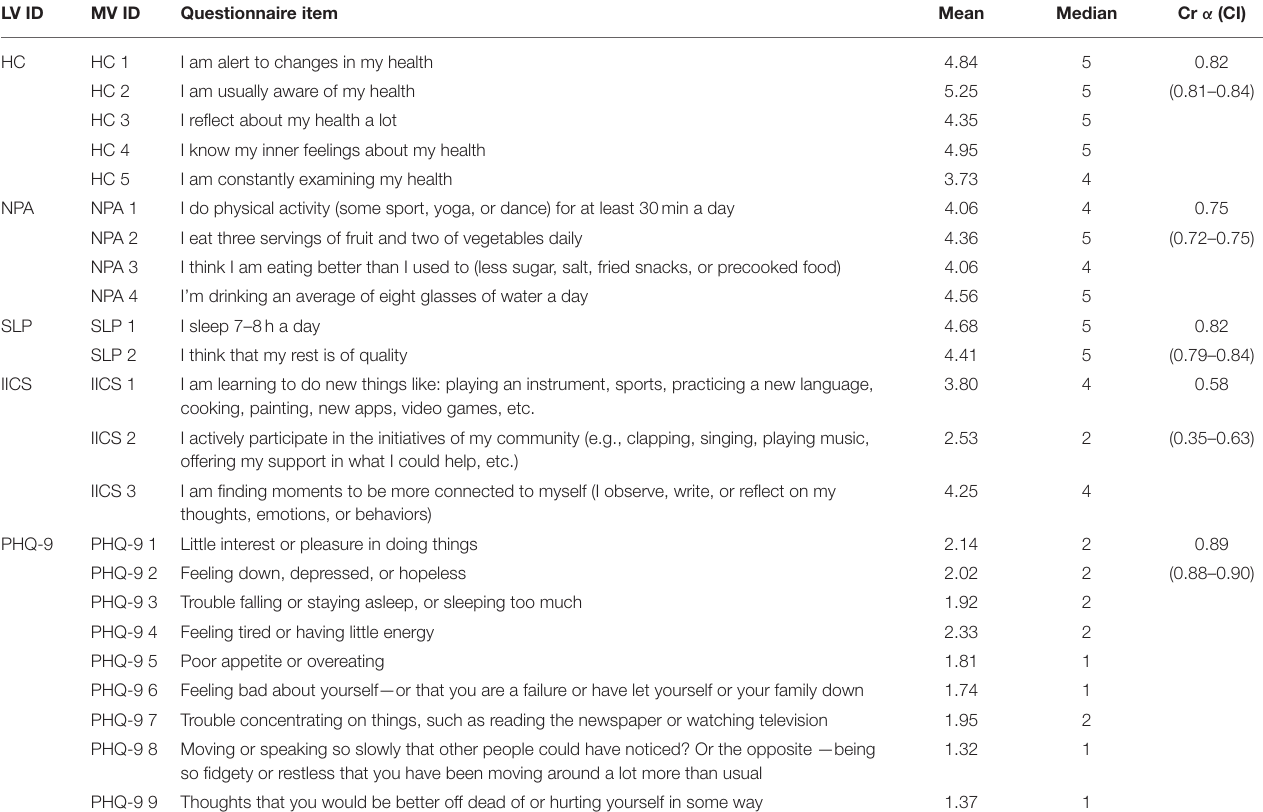
TABLE 1 | Description of the